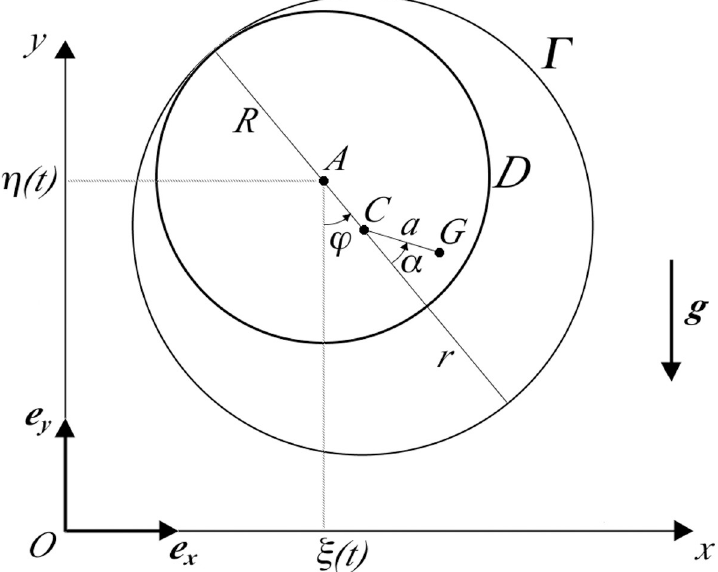
Fig 3. Simple model with loose nail-propeller coupling. A light pitchless propeller loosely mounted at the end of the rod by a nail to rotate freely. Another model of the device more appropriate for the case of a loose nail-propeller coupling. In the vertical plane Oxy the nail is represented by a rigid disk D of center A and radius R , animated by a purely translational motion whose description is given in terms of the varying coordinates ξ(t) , η (t) of A . The inner edge of the propeller hole, represented by the rigid circular ring Γ of radius r and center C , is assumed to roll without slipping on the outer profile of the nail D . Pure rolling requires static friction between Γ and D , but it does not invalidate the assumption of ideal constraints. The moment of inertia of the propeller with respect to the axis passing through its center of mass and orthogonal to Oxy is supposed to be known. The orthogonal projection G of the center of mass on the plane Oxy may not coincide with the center C of the ring Γ , as described by the distance a and the angle α . The propeller rotation is parametrized by the angle φ .